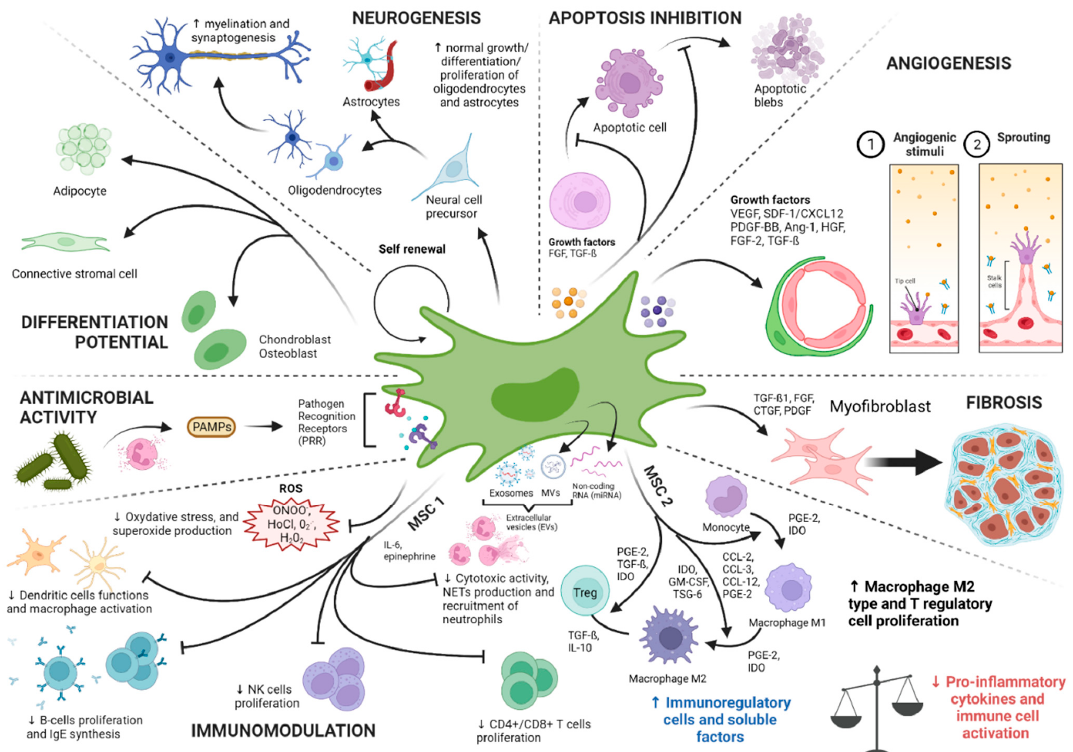
Figure 3. Representation of the different physiological roles attributed to MSCs according to their locations within different organs and their interactions with specific tissue-resident cell subpopulations. There are six major physiological roles associated with the MSC: (1) The capacity for neurogenesis represented by the potential for regeneration of myelin and synapses (pruning)